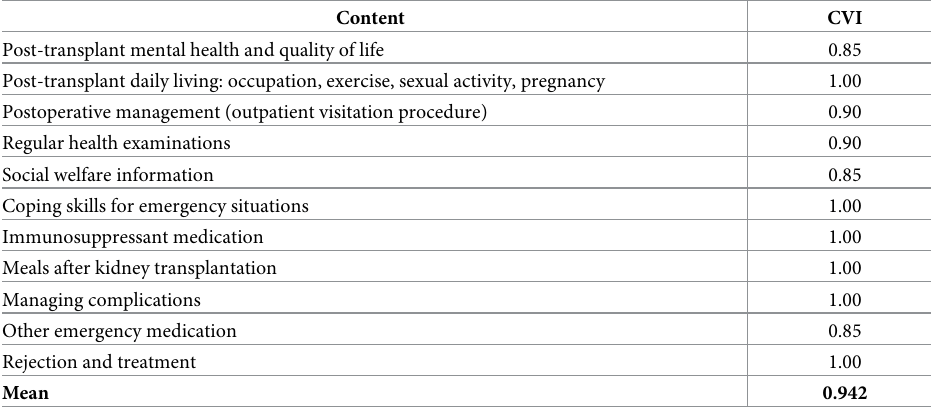
Table 4. Construction and expert validation of video-based educational content (N = 5).